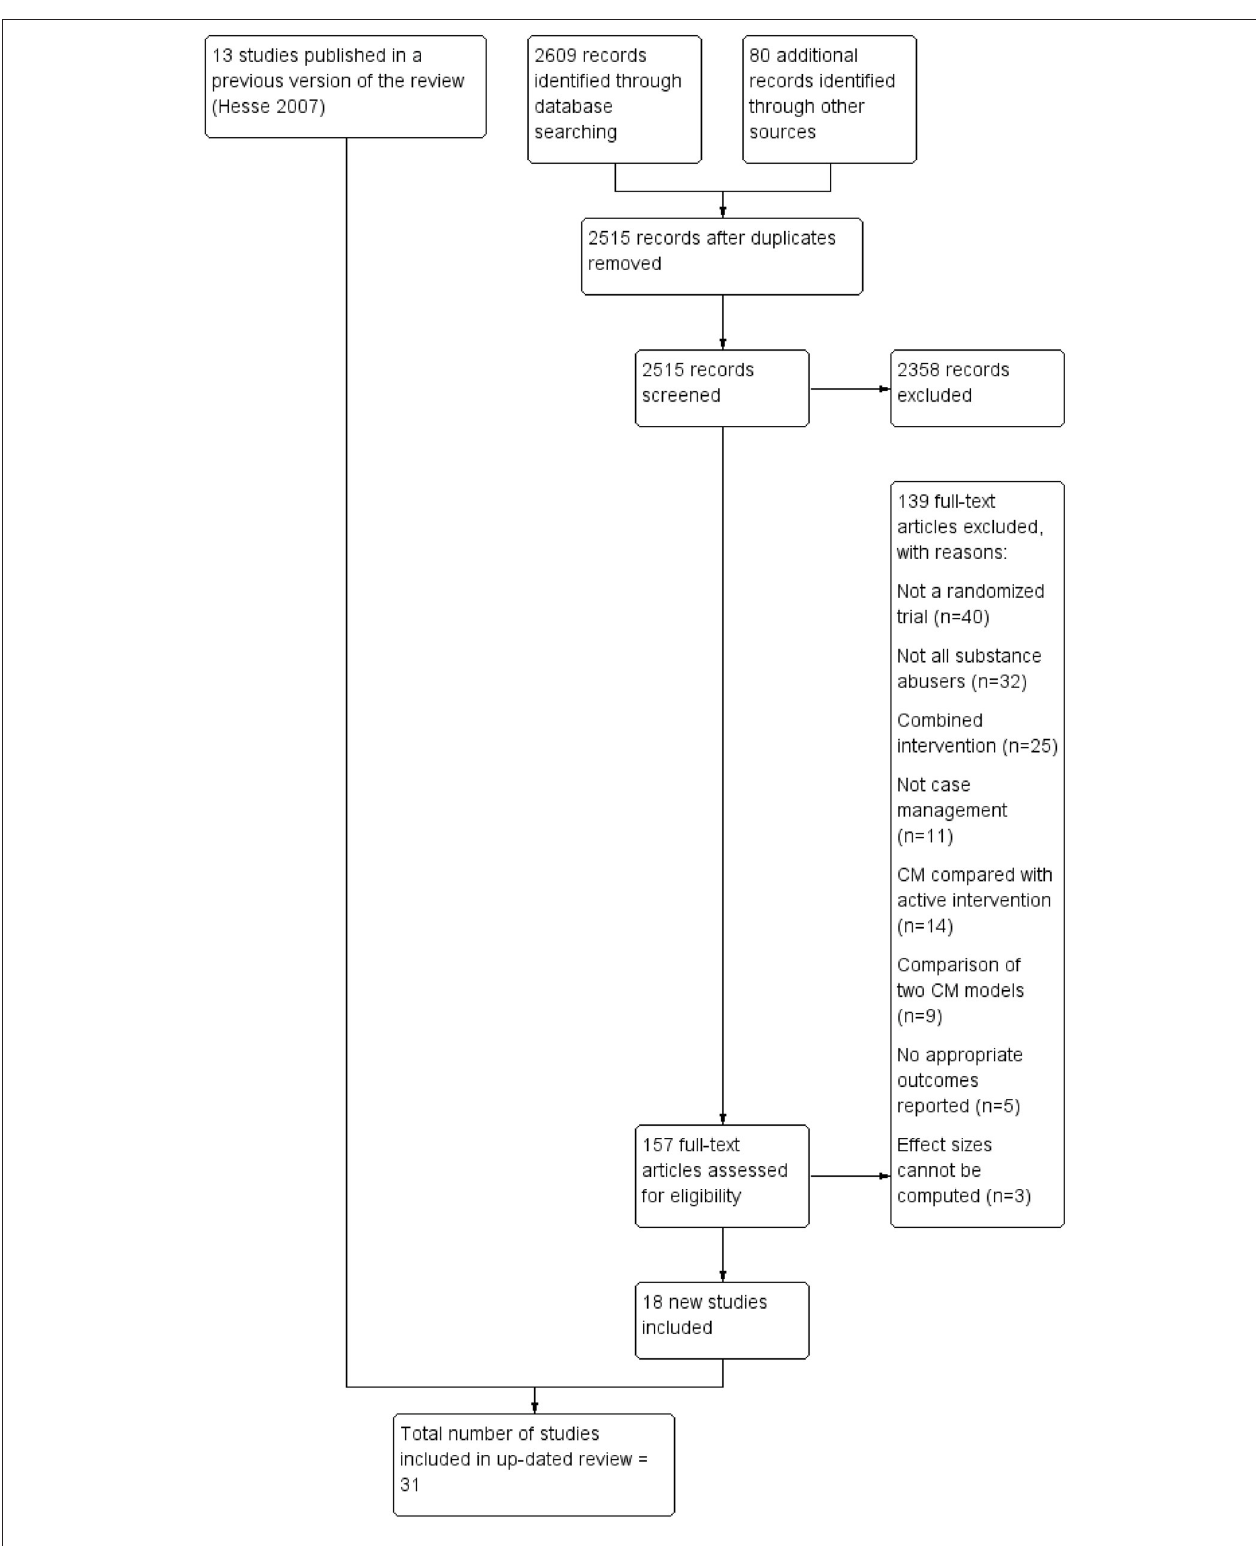
FIGURE 1 | PRISMA study flow